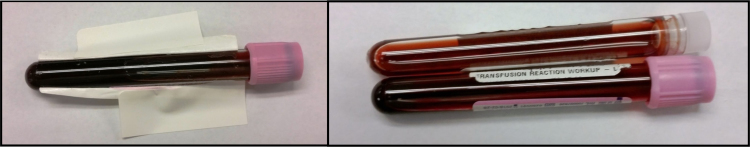
Photograph of grossly hemolyzed blood specimen.